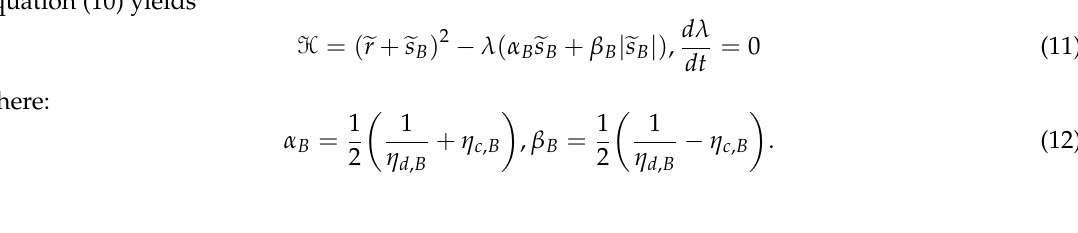
Figure 2. The overall block control scheme of the proposed OPEM.